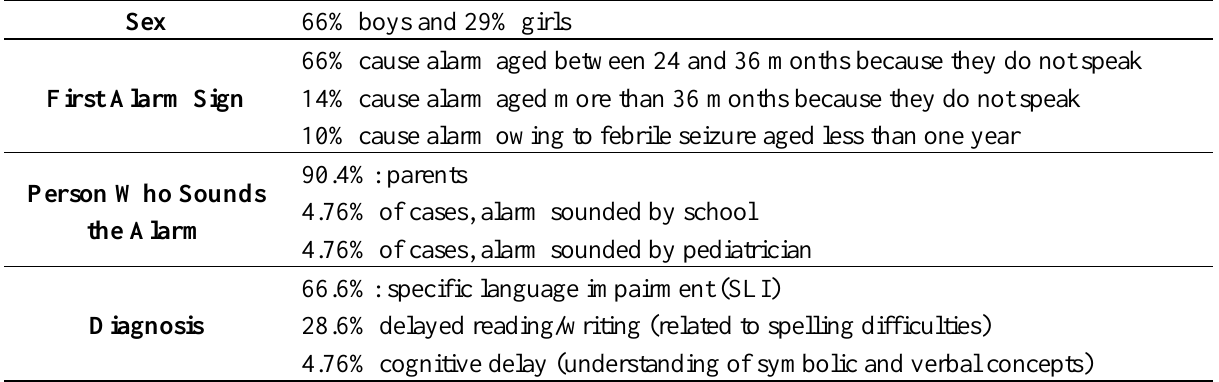
Table 2. Analysis of the 21 Language Intervention Center (LIC) cases used for refinement of the